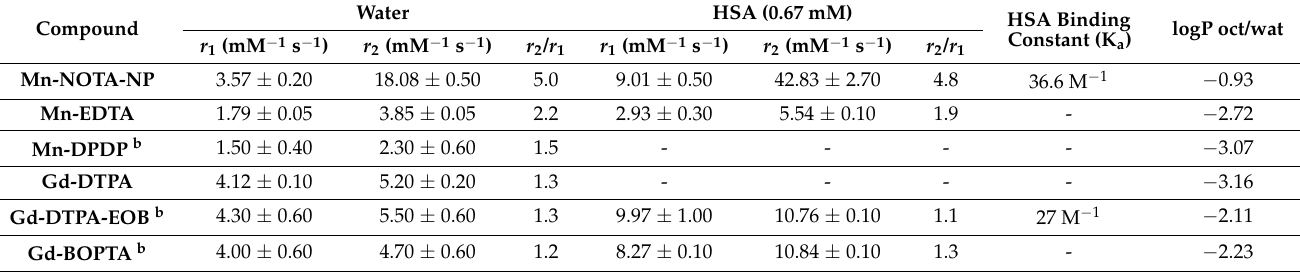
Table 1. Relaxivities and lipophilicity of Mn-NOTA-NP , Mn-EDTA, Mn-DPDP, Gd-DTPA, Gd- DTPA-EOB, and Gd-BOPTA in water and human serum albumin (HSA) at 3 T (297 K). Compound